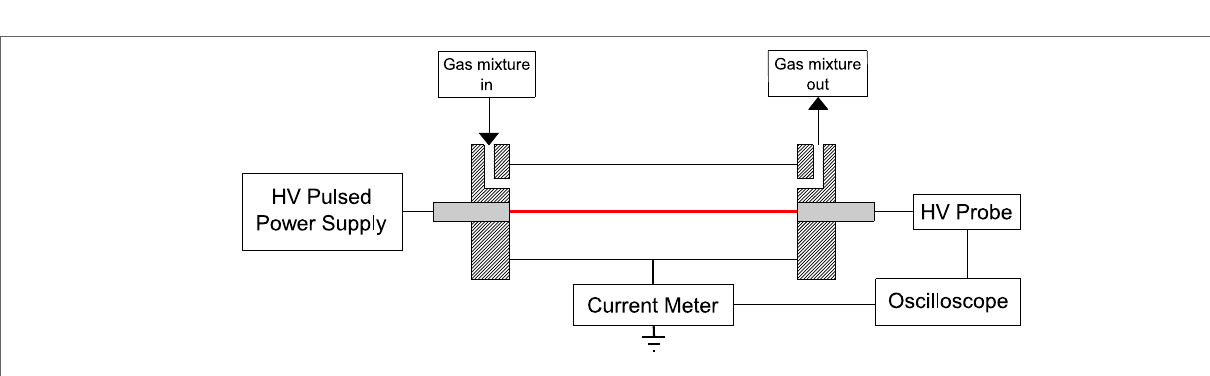
FigUre 4 | Pulsed plasma experimental schematic.